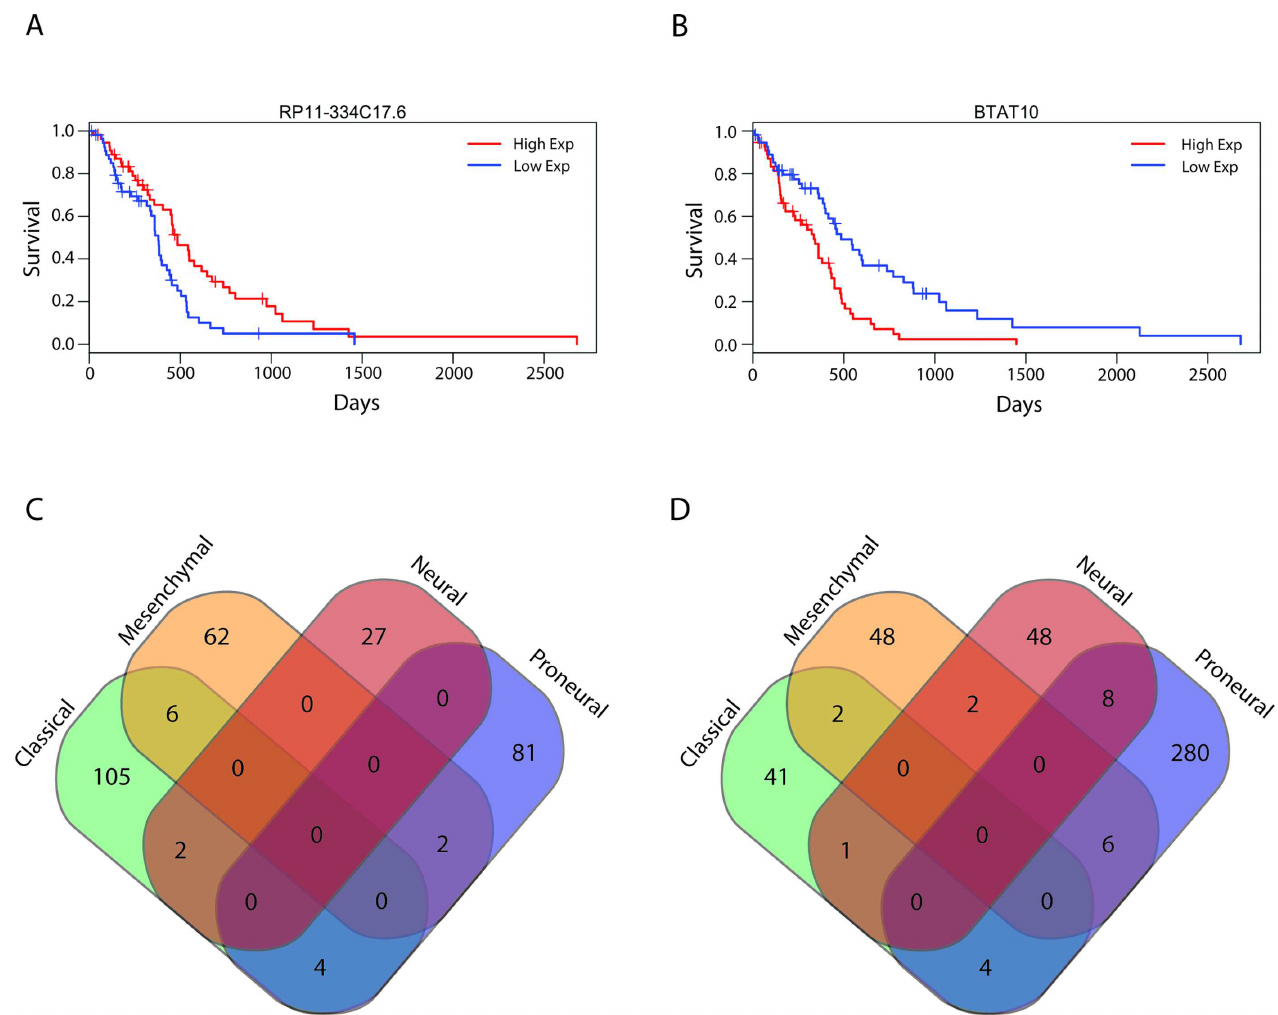
Fig 6. Survival-associated lncRNAs in GBMs and GBM subtypes. (A and B) Representative survival plots of lncRNAsthat predict survival in GBMs: RP11-334C17.6 (HR = 0.728, 95% CI = 0.6011–0.883, p = 0.00122) (A) and BTAT10 (HR = 1.298, 95% CI = 1.0881–1.548, p = 0.00374) (B). (C and D) lncRNAs associated with a poor prognosis (C) and good prognosis (D) in individual subtypes show minimaloverlap between subtypes. GBM, glioblastoma multiforme; HR, hazardratio; lncRNA, long noncoding